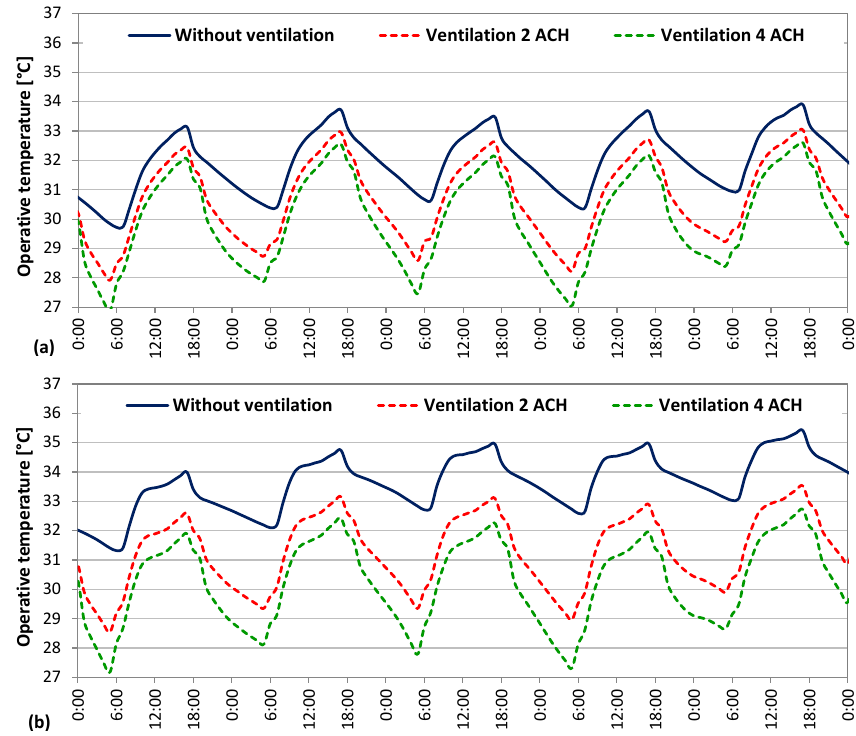
Figure 8. Effect of nighttime natural ventilation on the indoor operative temperature (from 5th to 10th August). ( a ): current building configuration; ( b ): case RP_3.